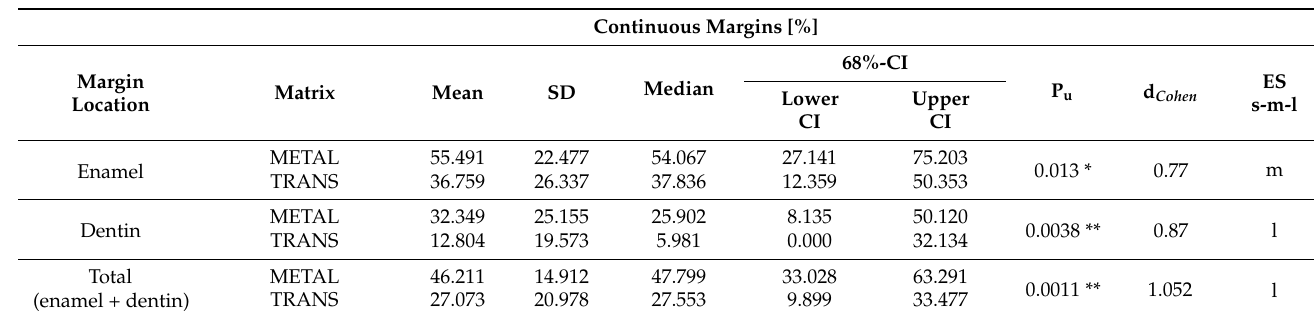
Table 3. Pairwise comparisons of the four test groups ( n = 20 each) according to the parameter matrix type and composite material (filling technique) in enamel and dentin; continuous margins [%] ( n = 20 per